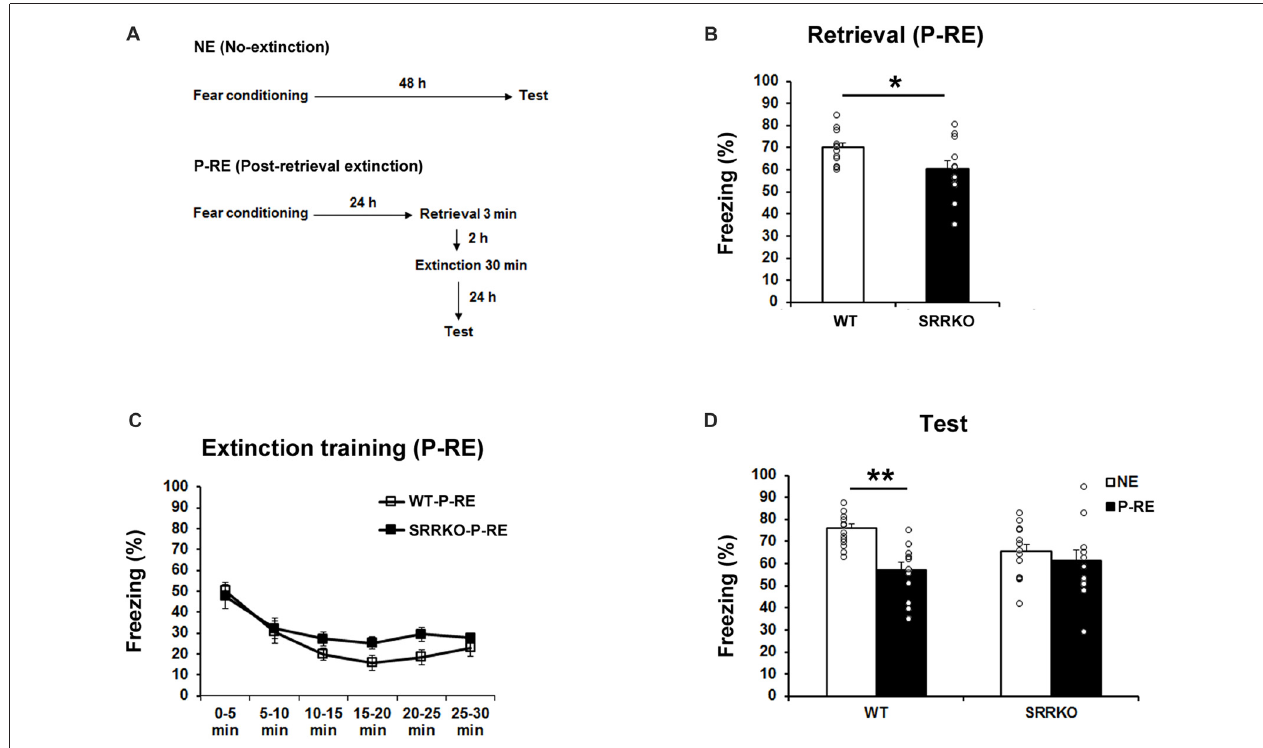
FIGURE 3 | Post-retrieval extinction (P-RE) of contextual fear memory is impaired in SRRKO mice. (A) Experimental schedule for contextual fear conditioning, P-RE and the recall test. (B) During the retrieval session, SRRKO-P-RE mice ( n = 12) exhibited significantly lower levels of freezing than did WT-P-RE mice ( n = 12; ∗ p < 0.05). (C) SRRKO-P-RE mice showed impaired within-session fear extinction during the P-RE training. (D) During the recall test, WT-P-RE mice exhibited significantly lower levels of freezing than did WT-NE mice (WT-NE, n = 13; ∗∗ p < 0.001). The freezing levels in SRRKO-P-RE and SRRKO-NE ( n = 13) mice were comparable. Data are presented as means ±